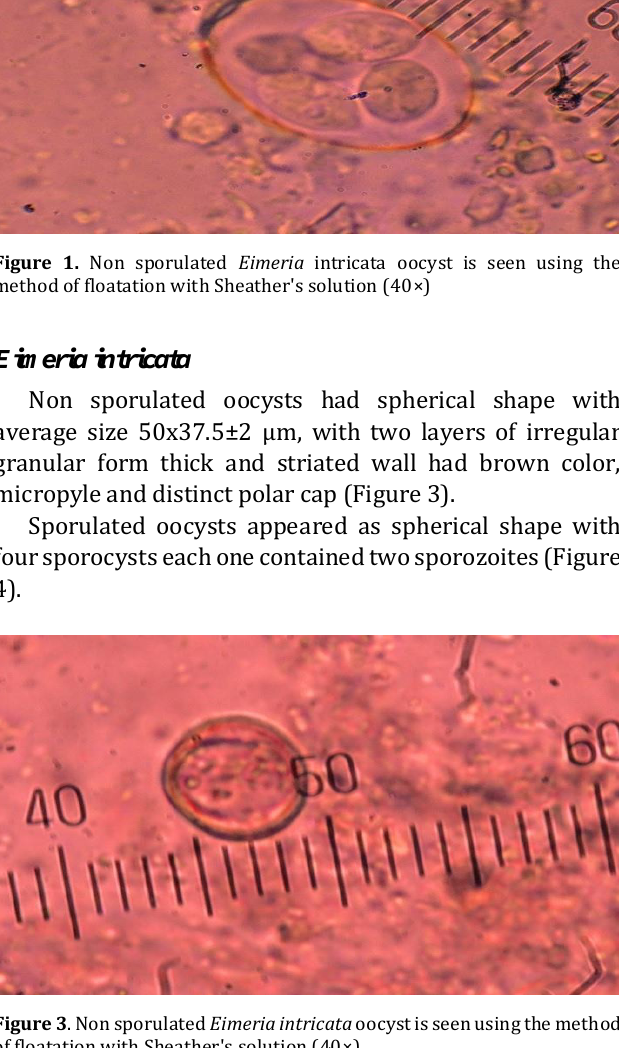
Figure 3 . Non sporulated Eimeria intricata oocyst is seen using the method of floatation with Sheather's solution